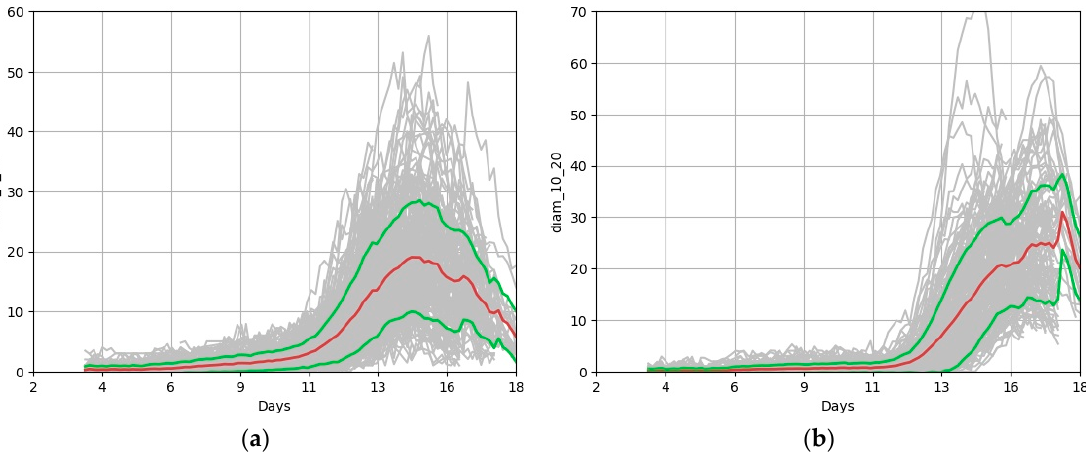
Figure 14. Number of mushrooms (pins) of diameter 5–10 mm ( a ), 10–20 mm ( b ). The brown line represents the medium value, the green line represents standard deviation.